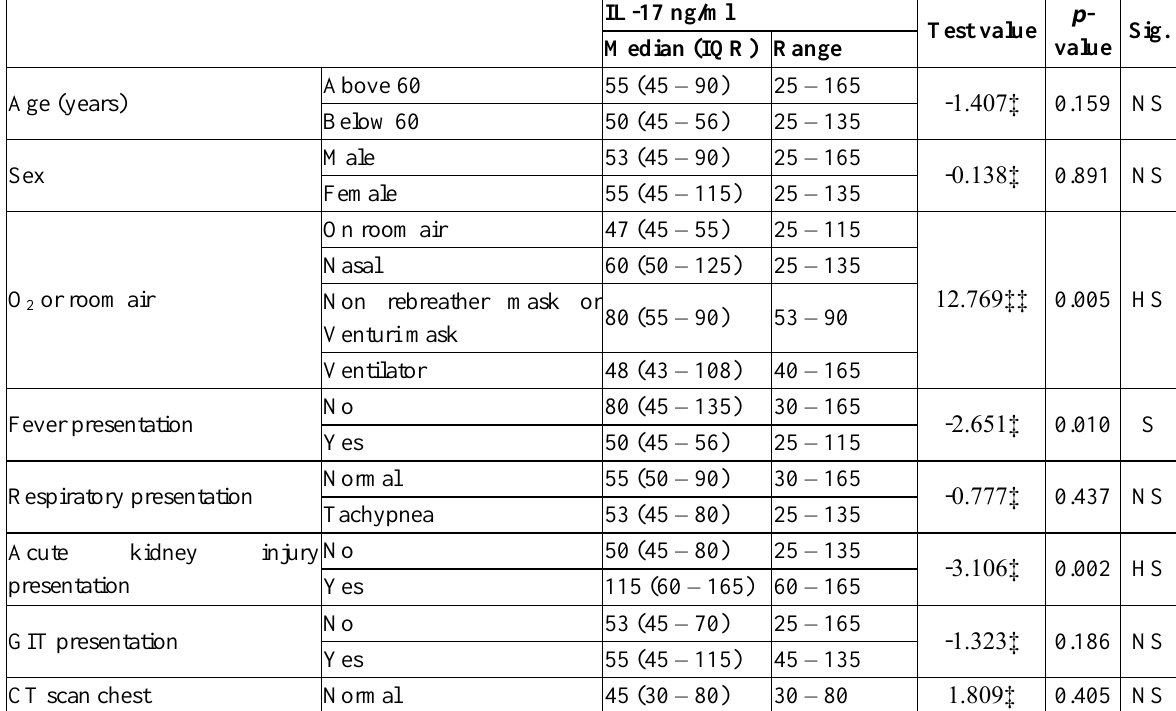
Table 2 . Correlation of serum IL-17 level with different demographic and clinical